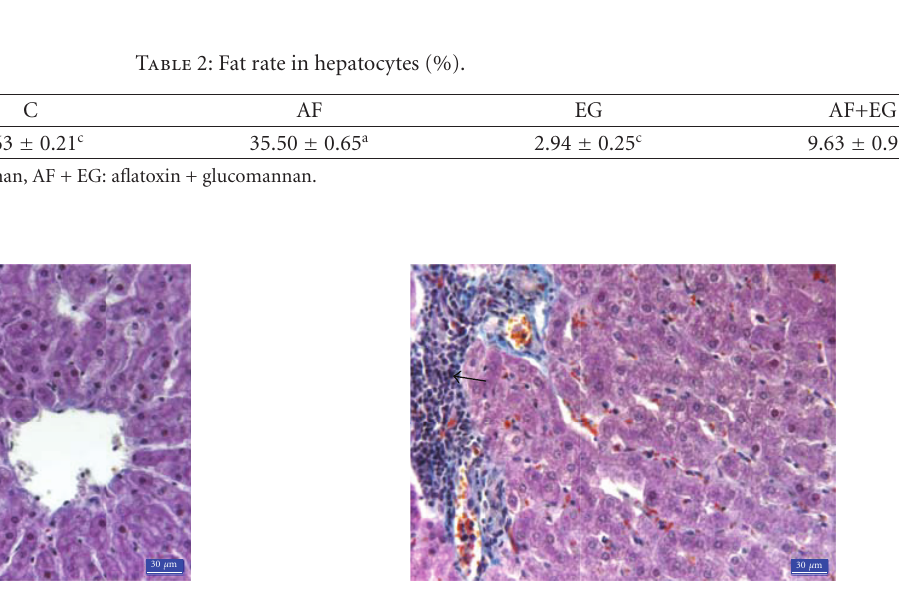
Figure 1: Normal histological appearance of the liver in the control group, 3rd region, trichrome staining.